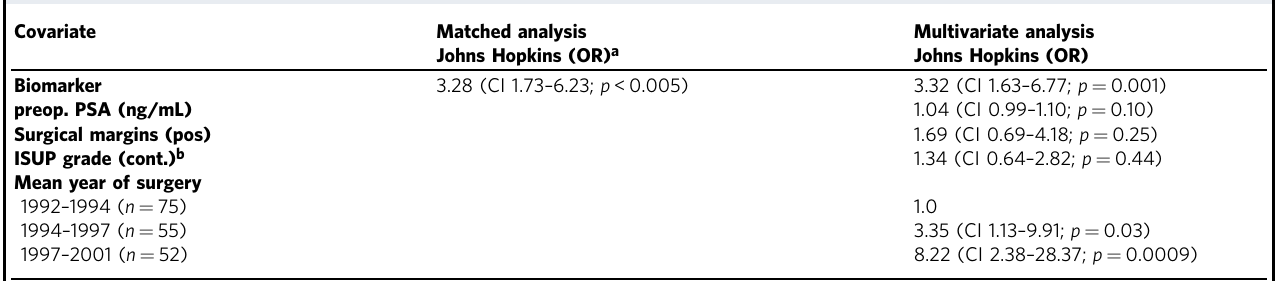
Table 3 Conditional logistic regression analyses of the Johns Hopkins test set. Covariate Matched analysis Johns Hopkins (OR)